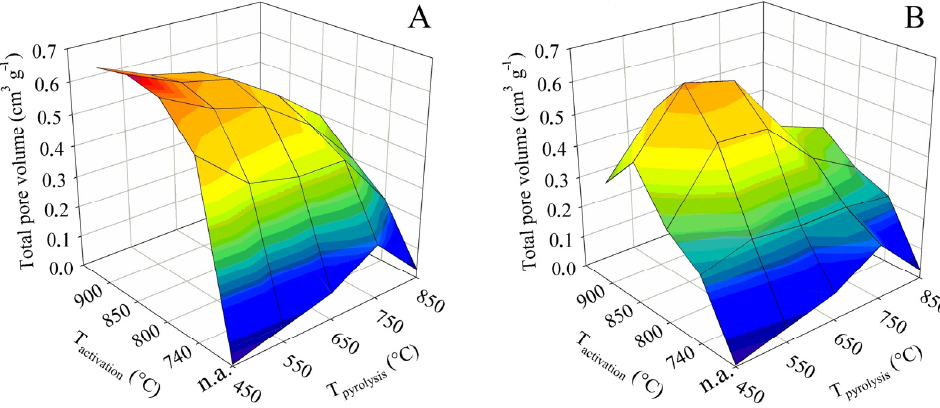
Figure 4. Changes in the total pore volume in dependence on pyrolysis and activation conditions for series ( A , B ).